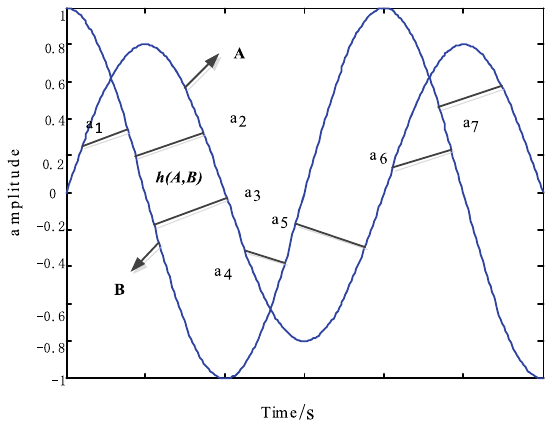
Fig. 4 The schematic diagram of the Hausdorff distance